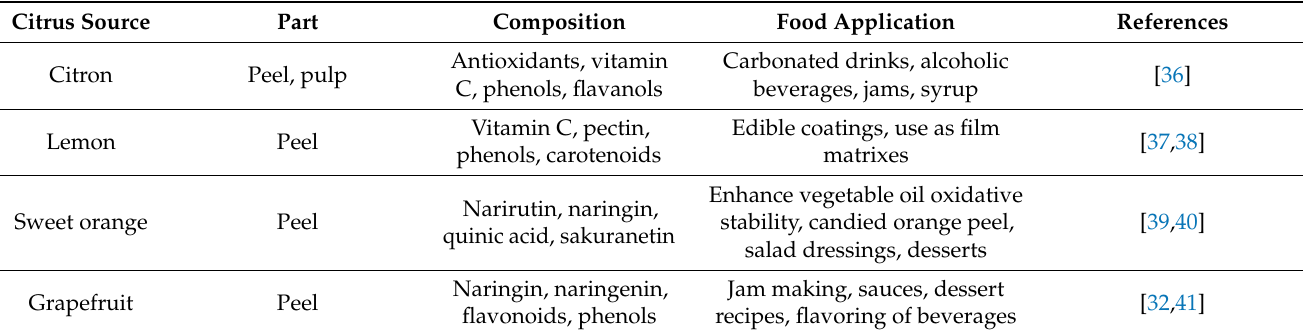
Table 1. Compositions and potential food applications of citrus fruits.